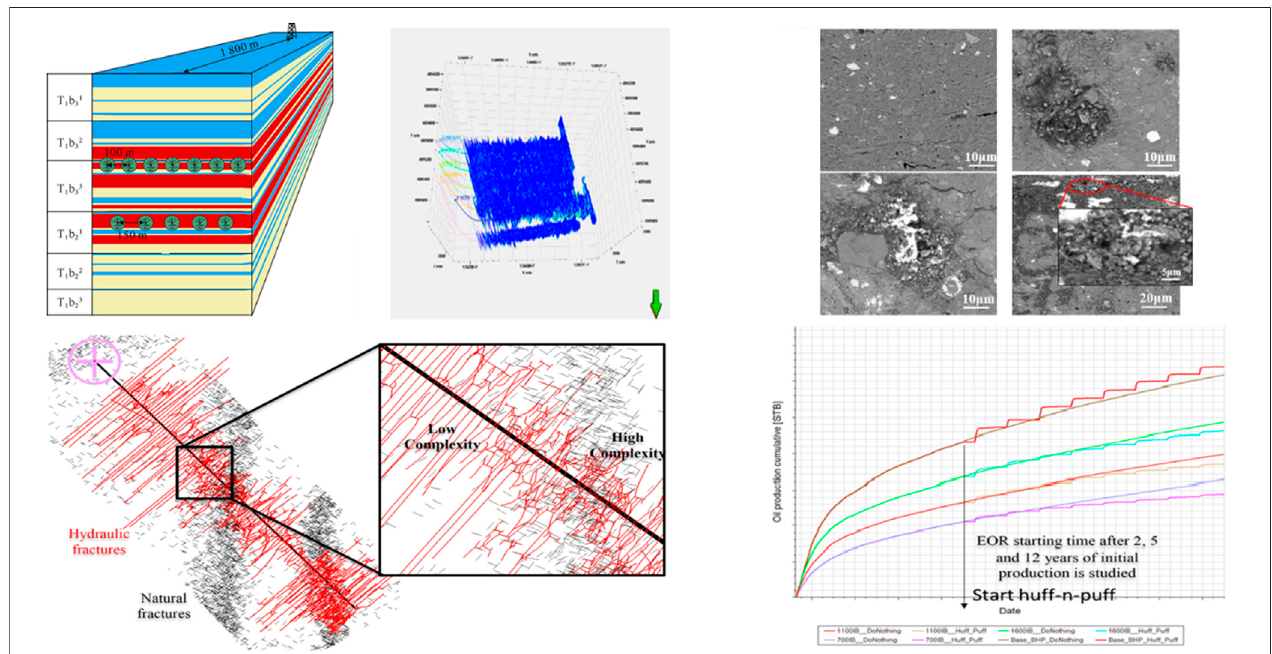
FIGURE 1 | Small-spacing stereo-staggered well pattern deployment technology and CO 2 injection (Pankaj et al., 2018; Li et al., 2020b; Tao et al., 2020).